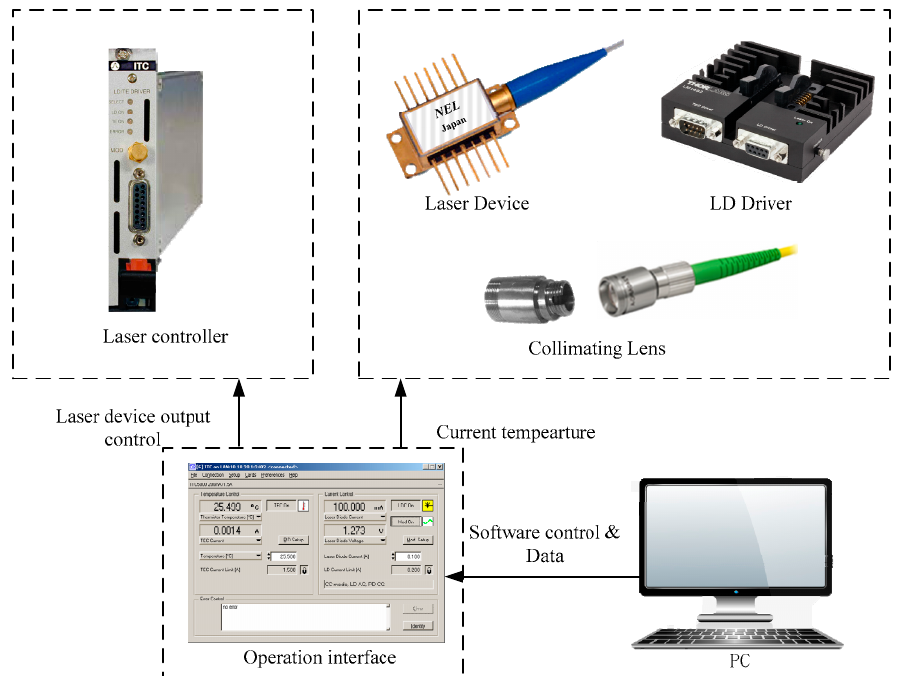
Figure 3. Structure diagram of the laser modulation system.